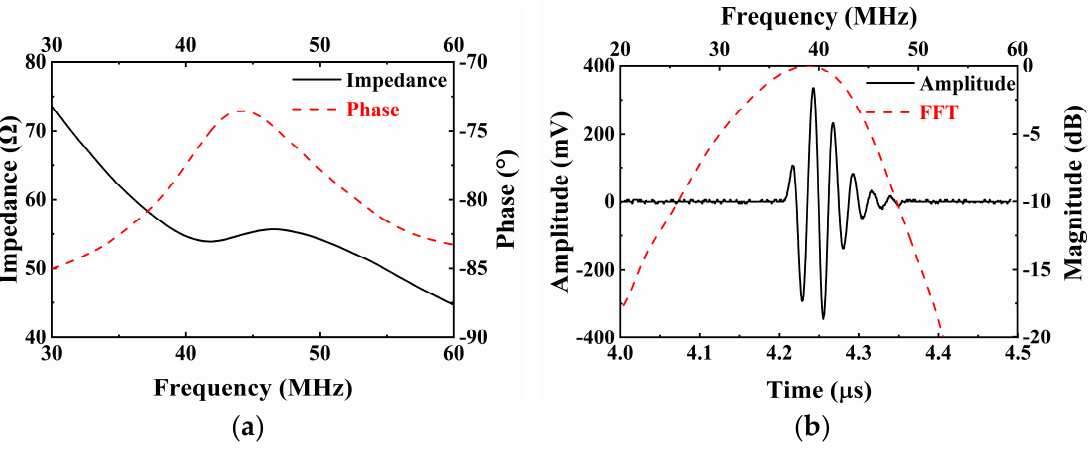
Figure 6. ( a ) Electrical impedance and phase of the NBT-Nb-Mn ultrasonic transducer; ( b ) pulse-echo response and normalized spectrum of the NBT-Nb-Mn ultrasonic transducers.